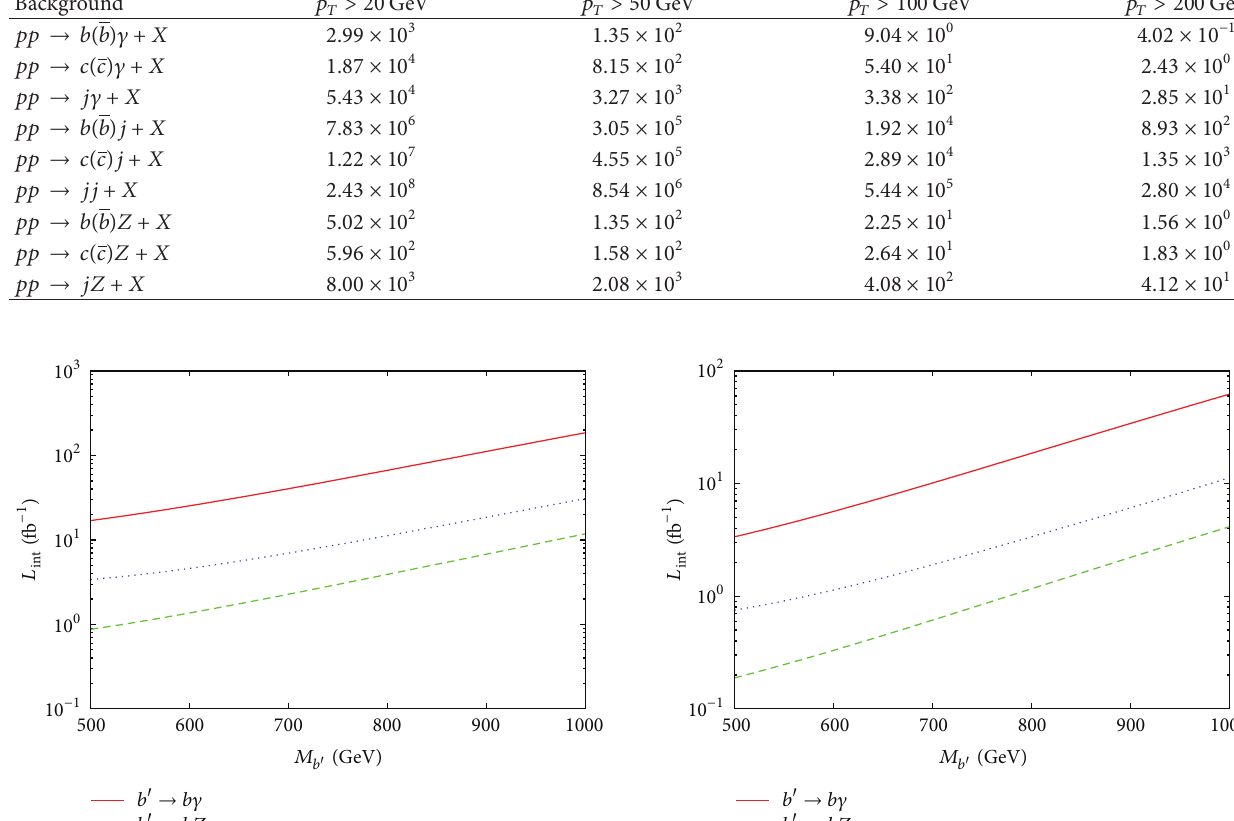
Table 14: The cross sections (in pb) for the backgrounds ( 𝑏(𝑏)𝑉 , 𝑐(𝑐)𝑉 , and 𝑗𝑉 , where 𝑉 = photon, jet, and 𝑍 boson) with 𝑝 𝑇 cuts on the jets and photon at the center of mass energy √𝑠 = 13 TeV.